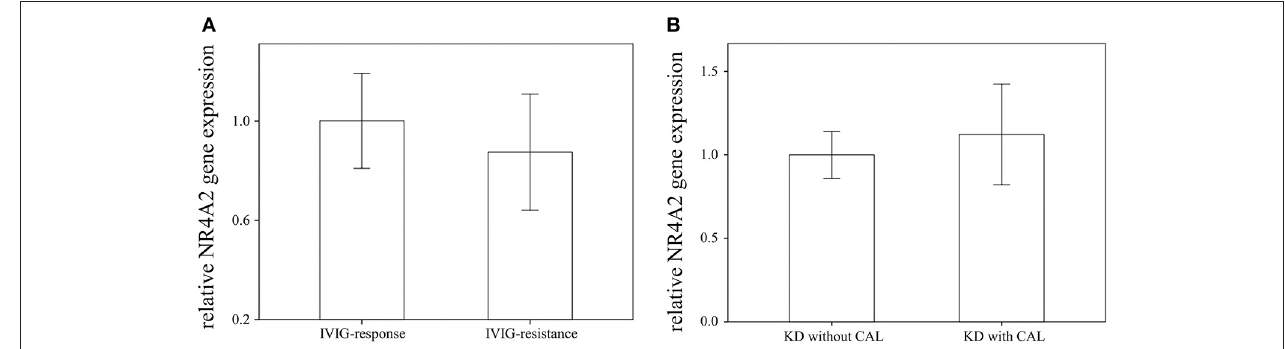
FIGURE 4 | Comparison of NR4A2 mRNA in KD patients (A) with intravenous immunoglobulin (IVIG) ( n = 6) resistance and without ( n = 42), as (B) well as with ( n = 28) without ( n = 20) coronary artery lesion (CAL). Data are presented as mean ± standard